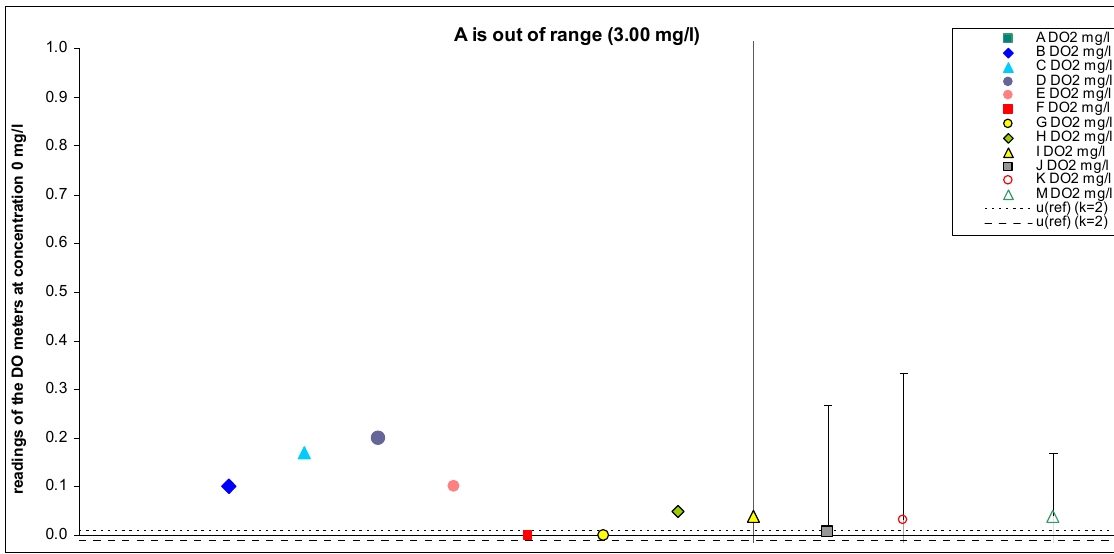
Table 12. Readings of participant instruments at DO concentration 0 mg/L a .